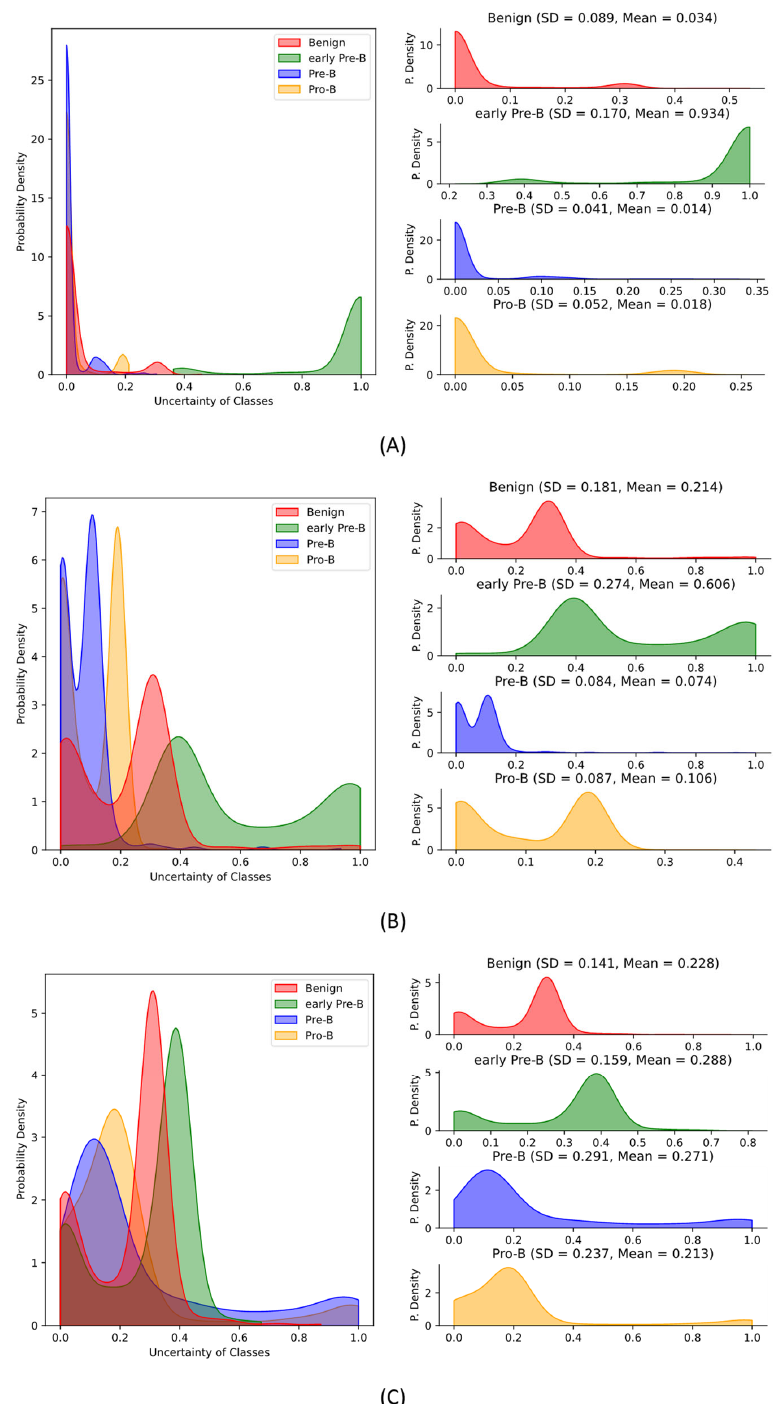
Figure 6. Examples of uncertainty quantification for ALL dataset using custom MLP-Mixer architecture: ( A ) correctly classified with low uncertainty; ( B ) correctly classified with high uncertainty; and ( C ) misclassified with high uncertainty.